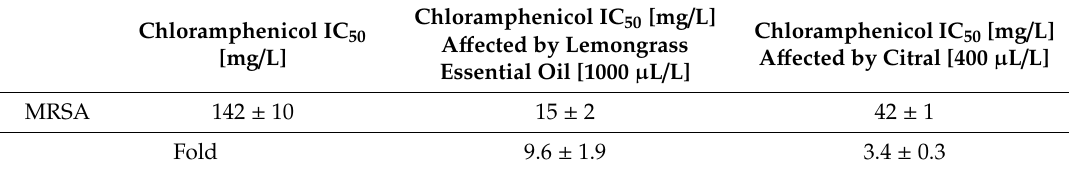
Table 2. Sensitization of methicillin-resistant Staphylococcus aureus (MRSA) by lemongrass essential oil and